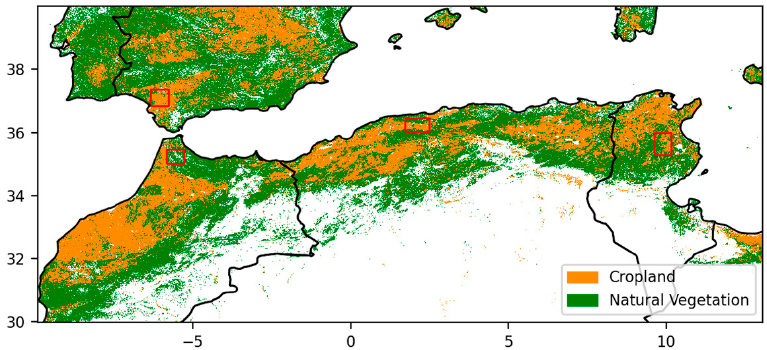
Figure 5. Simplified land use map with two classes: cropland and natural vegetation.